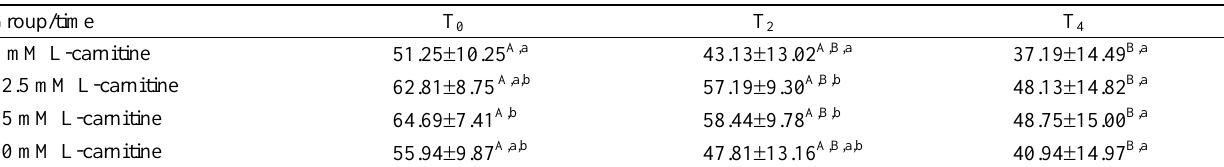
Table 2. Sperm motility (%) of post-thawed cauda epididymal spermatozoa after thawing for 0 h (T0), 2 h (T2) and 4 h (T4) in each experimental group (mean  SD) Group/time